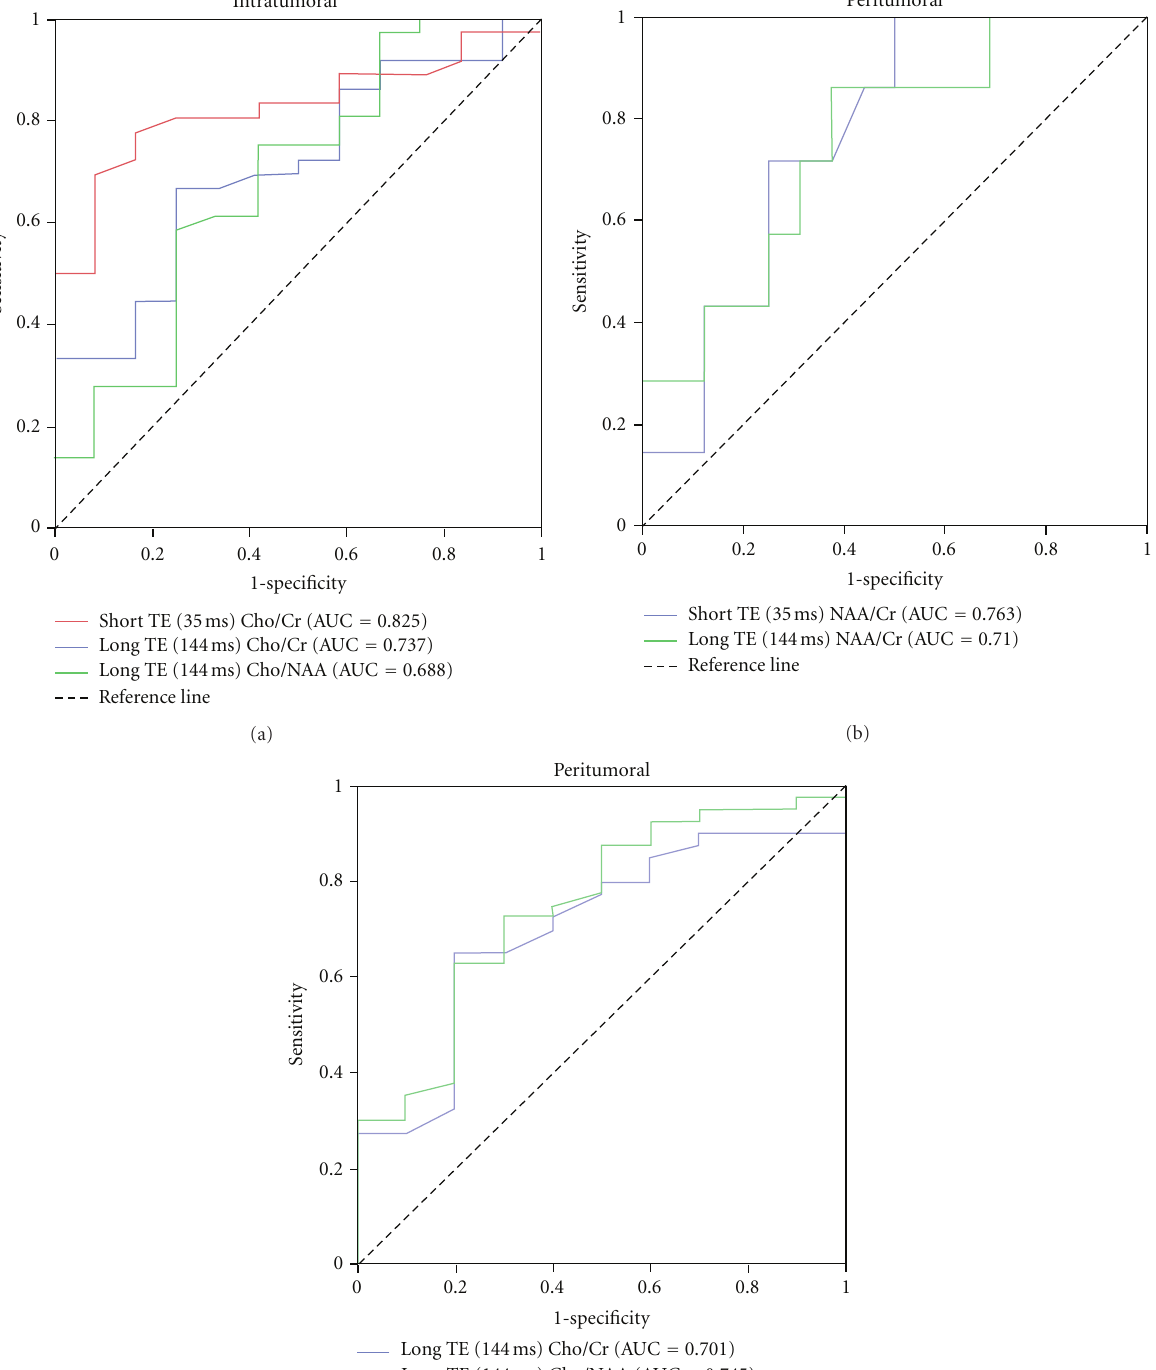
Figure 6: Upper graph (a) illustrates the receiver operating characteristic (ROC) curves of intratumoral short TE Cho/Cr and long TE Cho/Cr and Cho/NAA ratios. Lower graphs illustrate ROC curves of peritumoral short TE NAA/Cr, long TE NAA/Cr (b) and long TE Cho/Cr and Cho/NAA (c) ratios, for di ff erentiating low from high grade